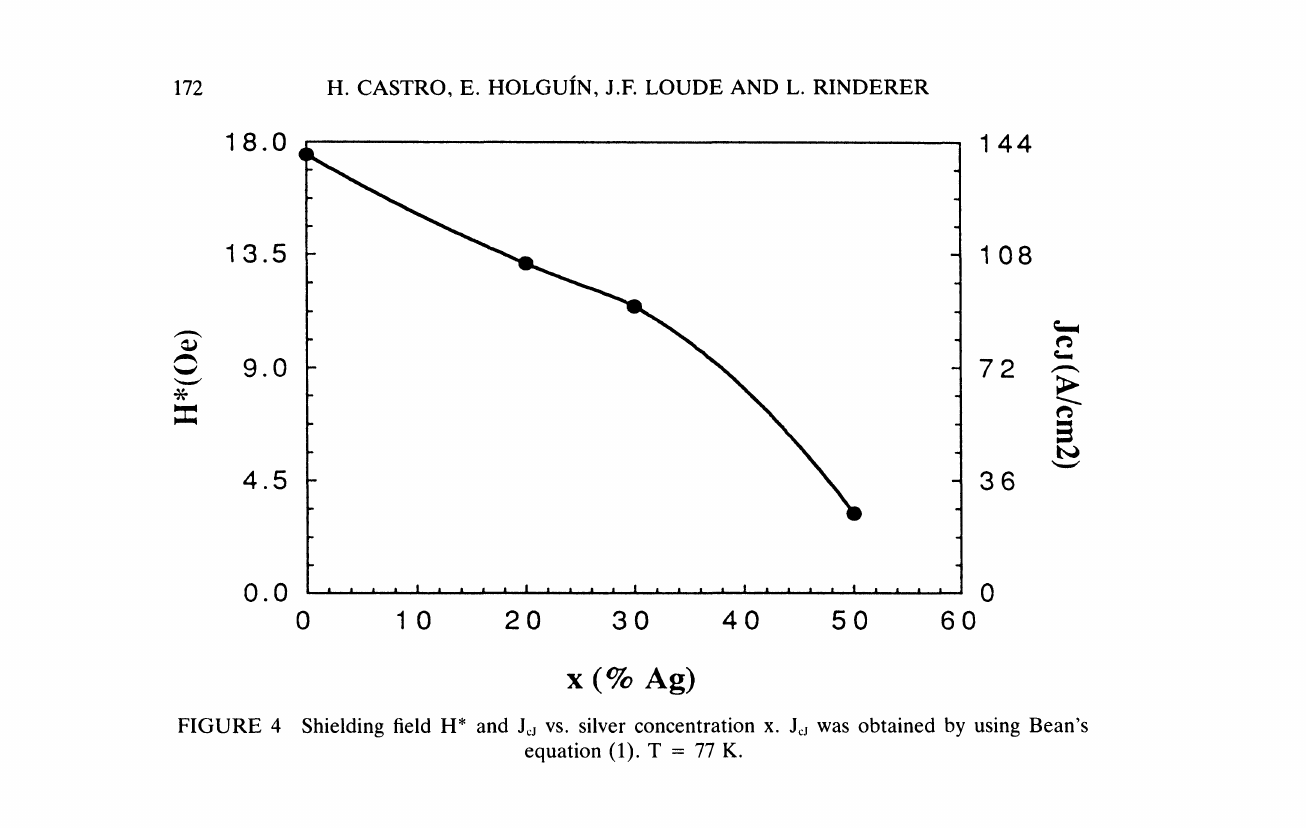
10 20 30 40 50 60 x (% Ag) FIGURE 4 Shielding field H* and JcJ vs. silver concentration x. Jcj was obtained by using Bean’s equation (1). T 77